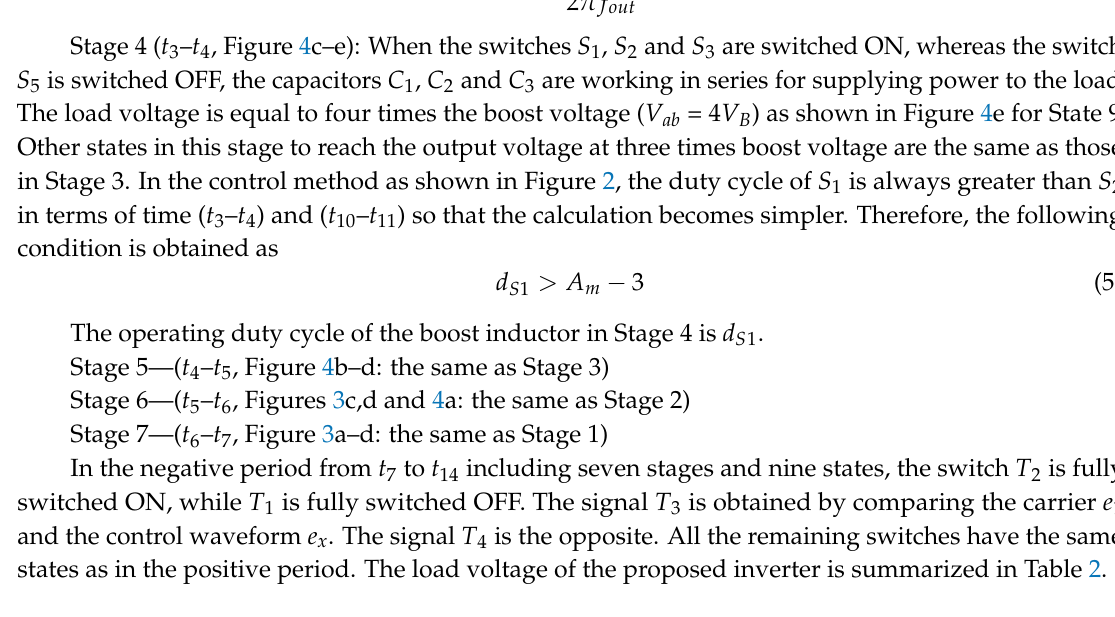
Table 2. Different Switching, Capacitor, and Inductor States of the Proposed NLBI. State Stage ON Diodes ON Switches